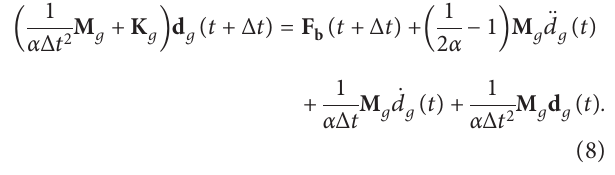
Figure 1: Notations of a simple bar-joint